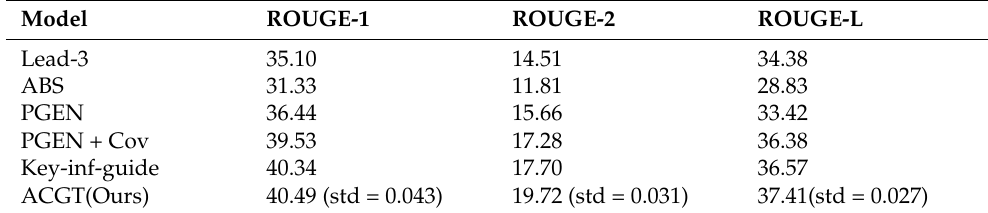
Table 3. ROUGE score of each model on CNN/DM dataset.